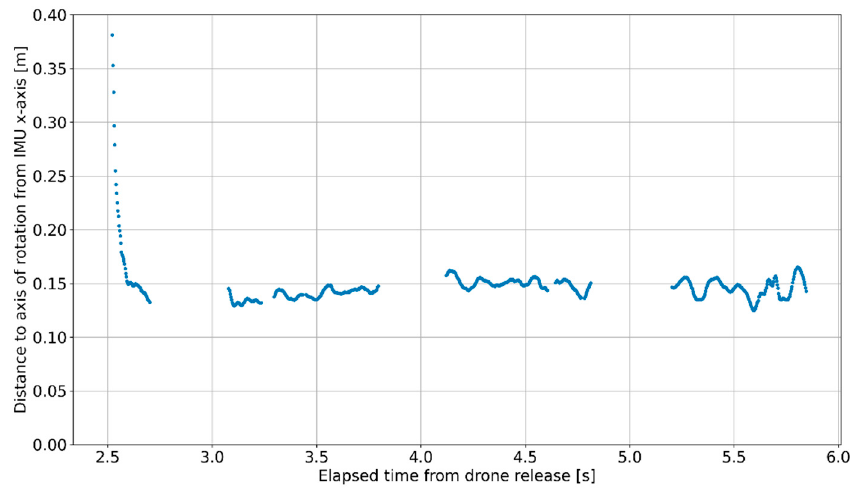
Figure 19. Distance to axis of rotation from IMU centre for TA2 2.5 < t < 6 s.